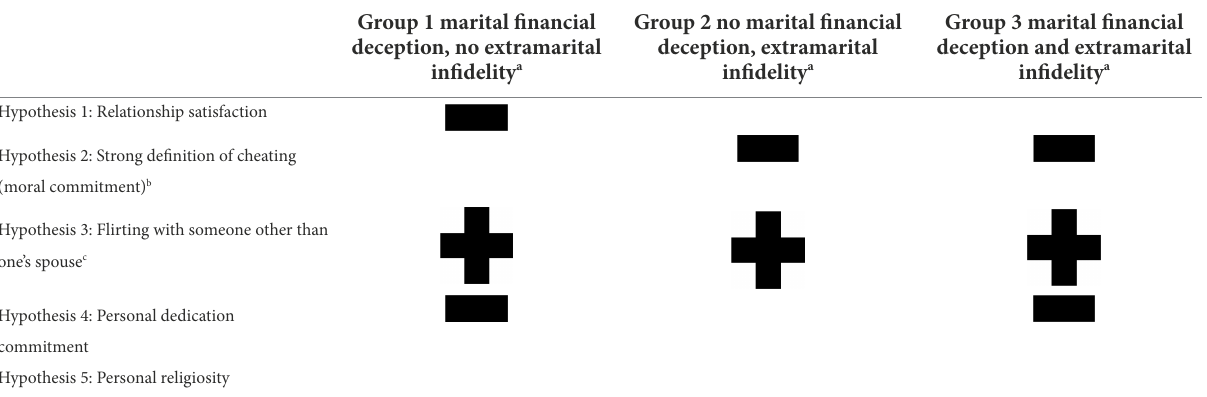
TABLE 3 Summary of